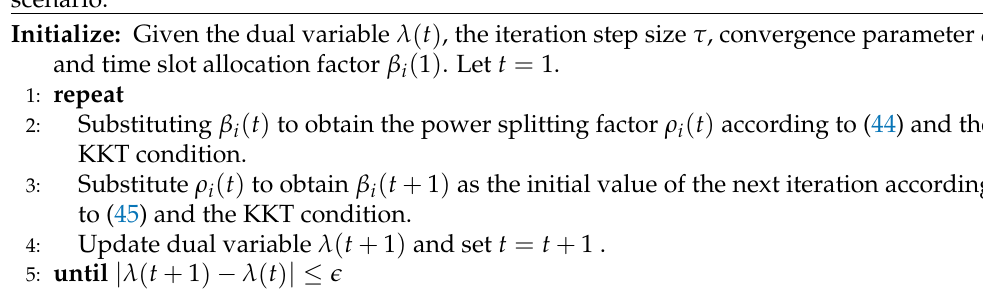
Algorithm 2 Proposed algorithm for the joint optimization problem in the MR-TWRS